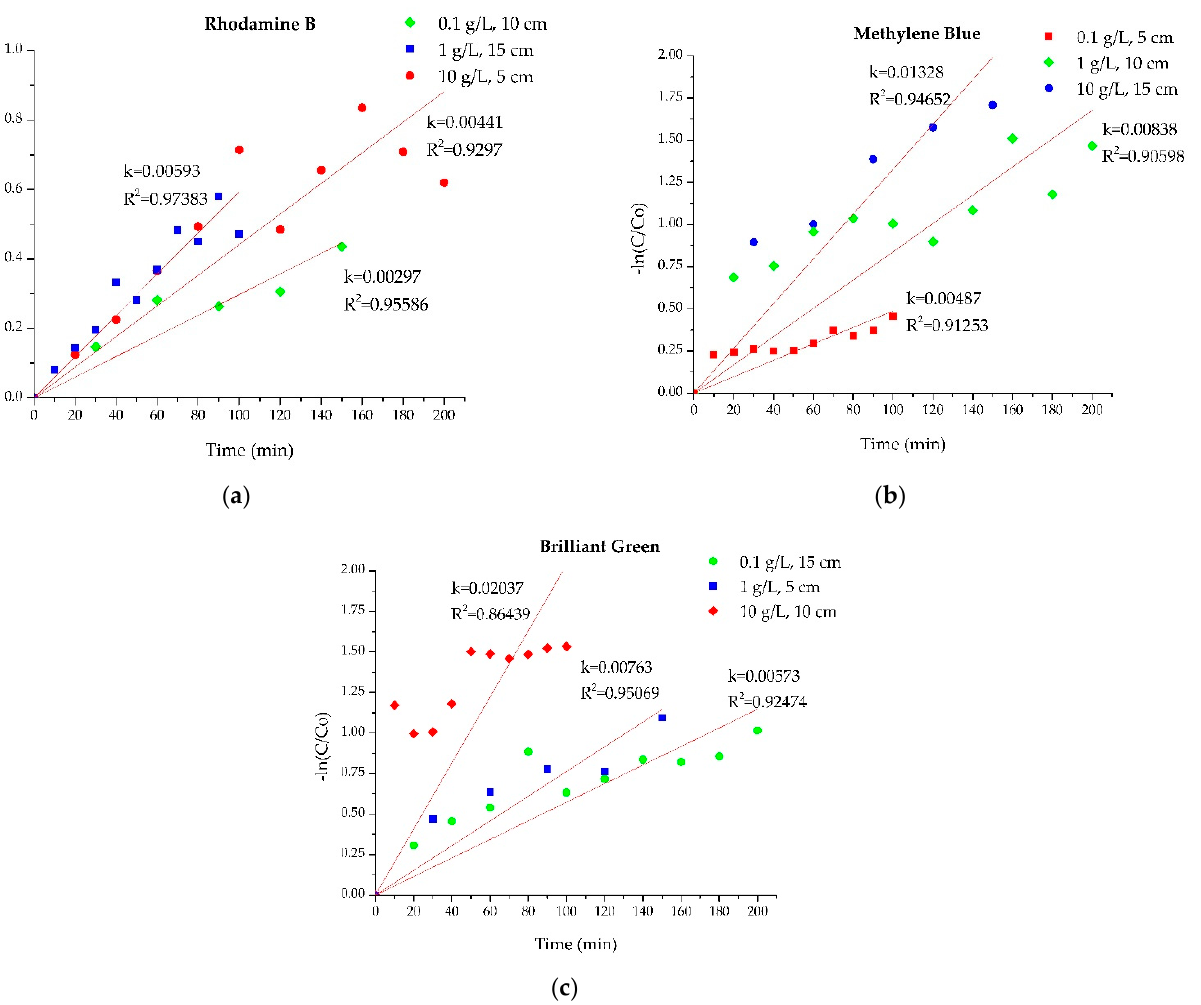
Figure 11. Photocatalytic kinetics under visible light irradiation for ( a ) Rhodamine B, ( b ) Methylene Blue, and ( c ) Brilliant Green.